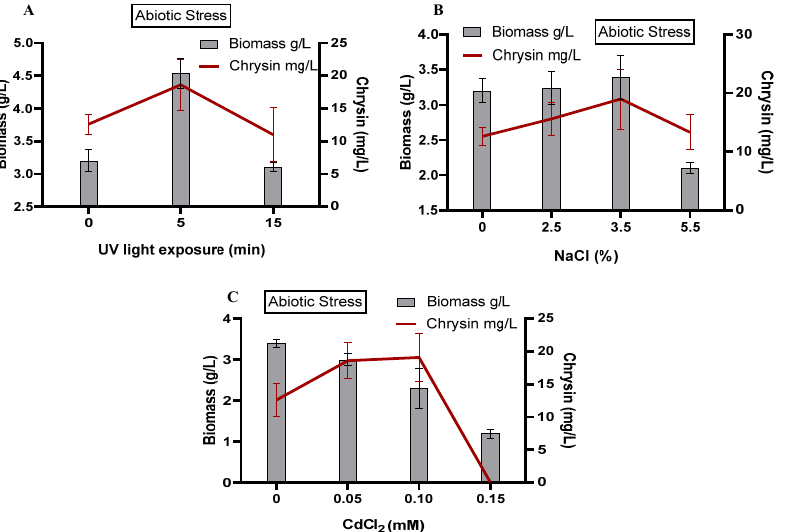
Figure 4. Effect of abiotic elicitors on C. globosum biomass and production of chrysin. ( A ) UV radiation exposure; ( B ) Salinity stress (NaCl doses); ( C ) Metal stress (CdCl 2 ).